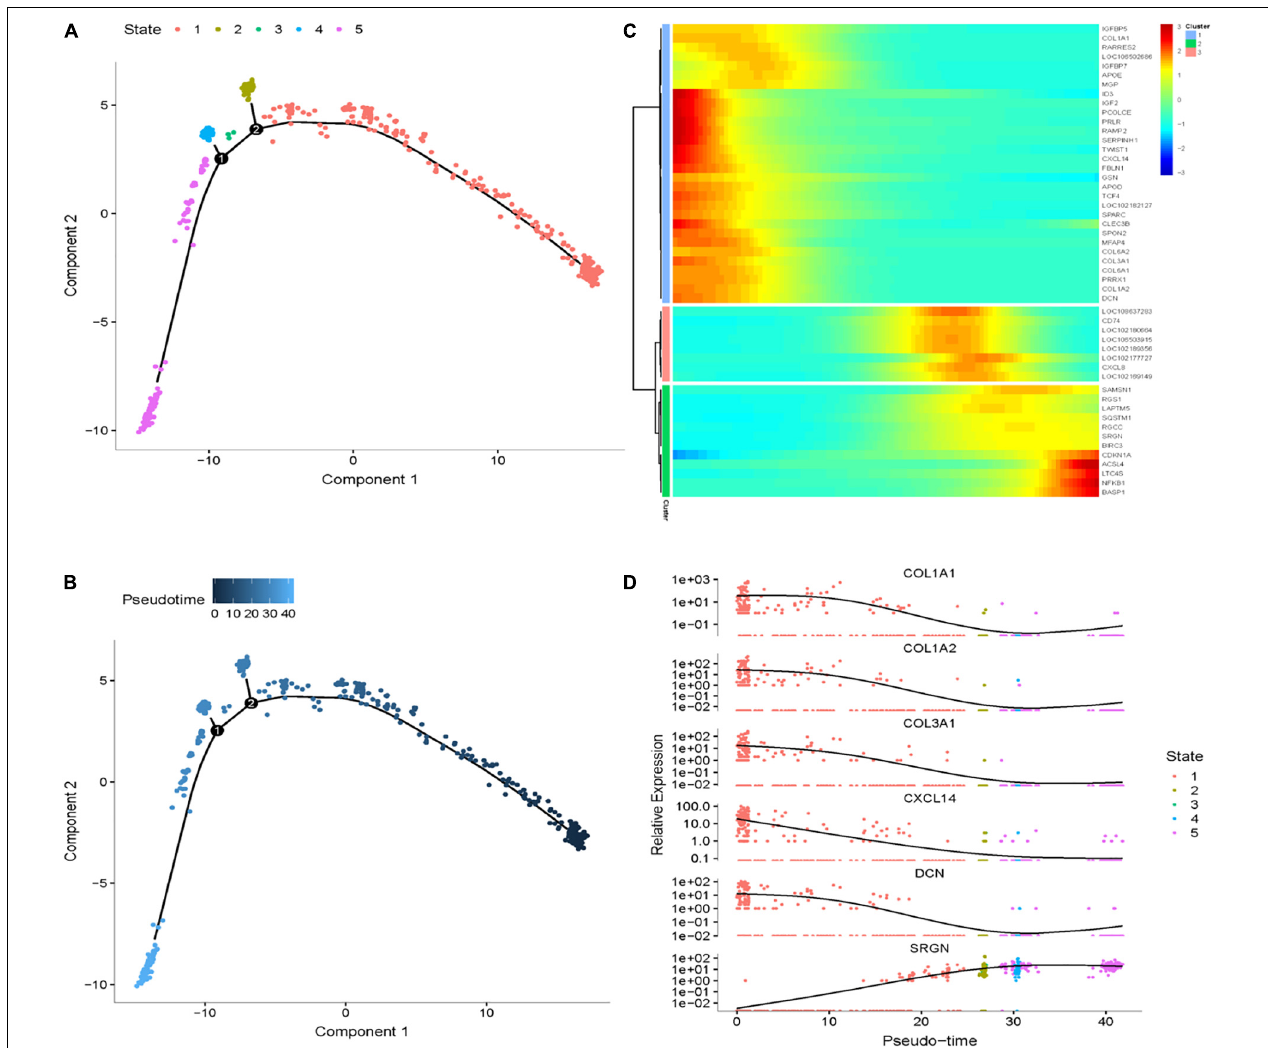
FIGURE 8 | Cell trajectory analysis in SDPCs of goat skin. (A) Monocle 2 cell trajectory of goat DPCs. (B) Pseudo-time is displayed in a dark to light blue gradient and indicates the start of pseudo-time. (C) Clustering of top 50 genes exhibiting in SDPCs. (D) Expression levels of six responsive genes in DPCs. X -axis represents pseudo-time, Y -axis represents gene expression